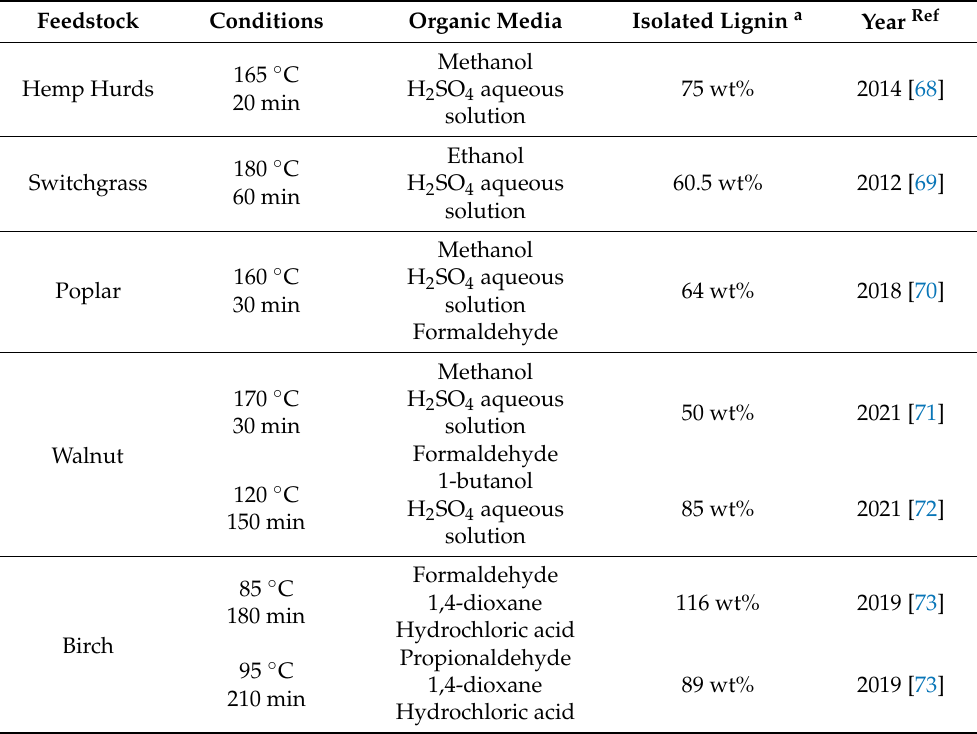
Table 3. Solvent- or co-solvent-assisted lignin extraction from biomass feedstock.